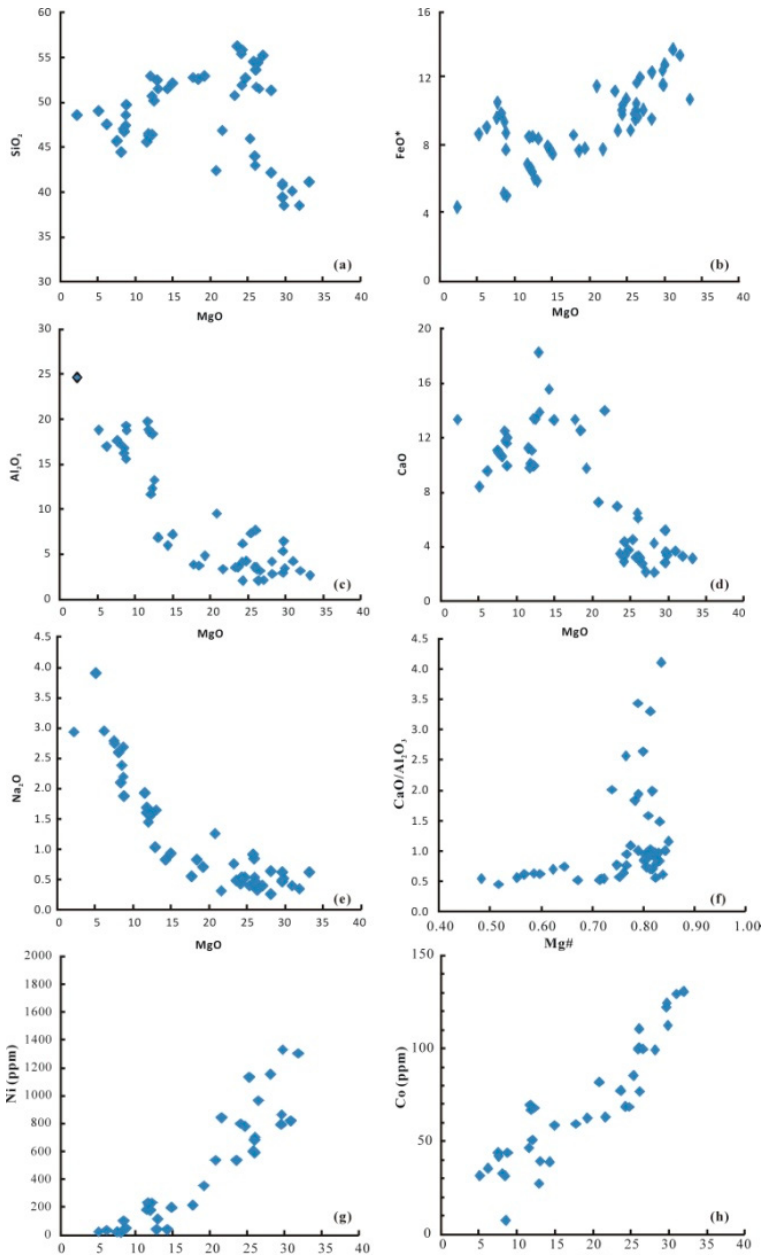
Figure 9. Other oxides and trace elements versus MgO plots and CaO/Al 2 O 3 versus Mg# from the Xingdi No.2 intrusive rocks. ( a ) SiO 2 versus MgO; ( b ) FeO* versus MgO; ( c ) Al 2 O 3 versus MgO; ( d ) CaO versus MgO; ( e ) Na 2 O versus MgO; ( f ) CaO/Al 2 O 3 versus Mg#; ( g ) Ni versus MgO; ( h ) Co versus MgO.